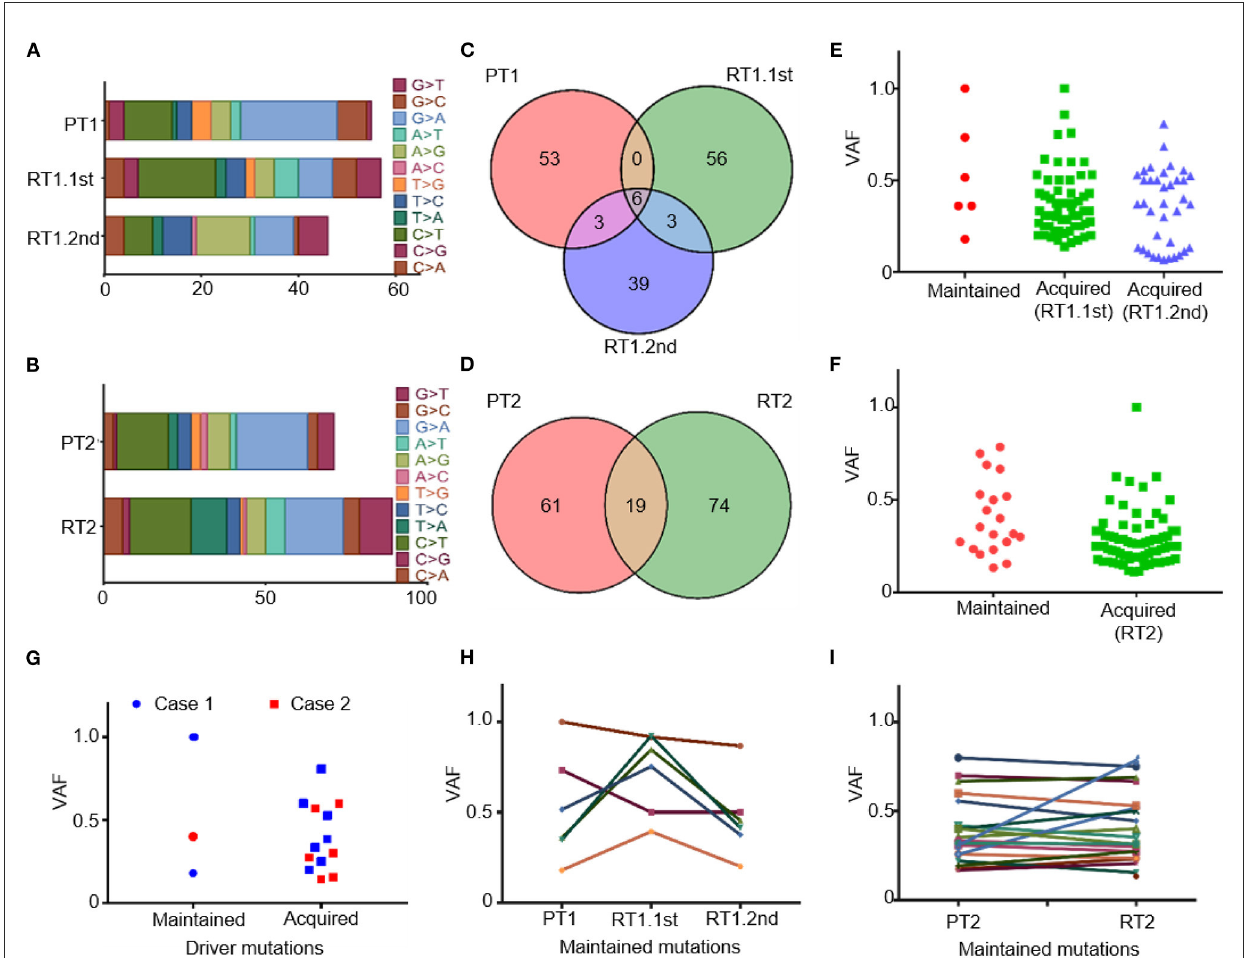
FIGURE3 Somatic mutations of the primary and matched sub-frontal recurrent MBs by WGS. (A, B) Altered spectrum of somatic SNPs. (C, D) Venn diagram showed a paucity of overlap in somatic mutational events between the matched primary and sub-frontal recurrent MBs. (E, F) Statistics of the maintained and acquired somatic mutations in sub-frontal recurrent MBs showed the majority of mutations were acquired at tumor recurrence. (G) Statistics of the paired MBs showed much more driver mutations in the recurrences. (H, I) The VAF of the maintained somatic mutations kept changing throughout the tumor progression. VAF, variant allele